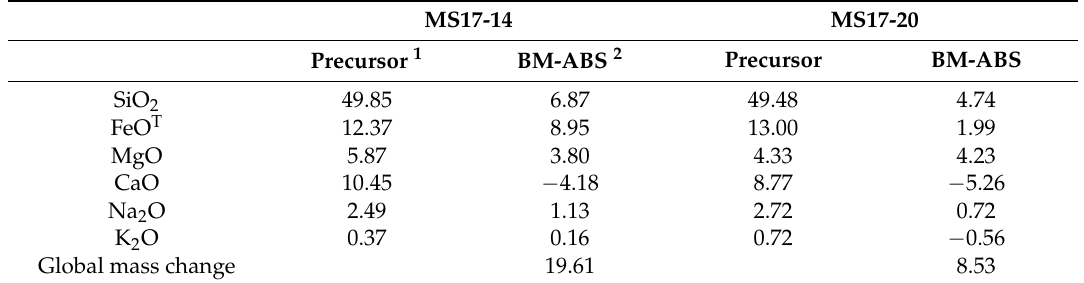
Table 5. Results of mass balance calculations performed on volcanic